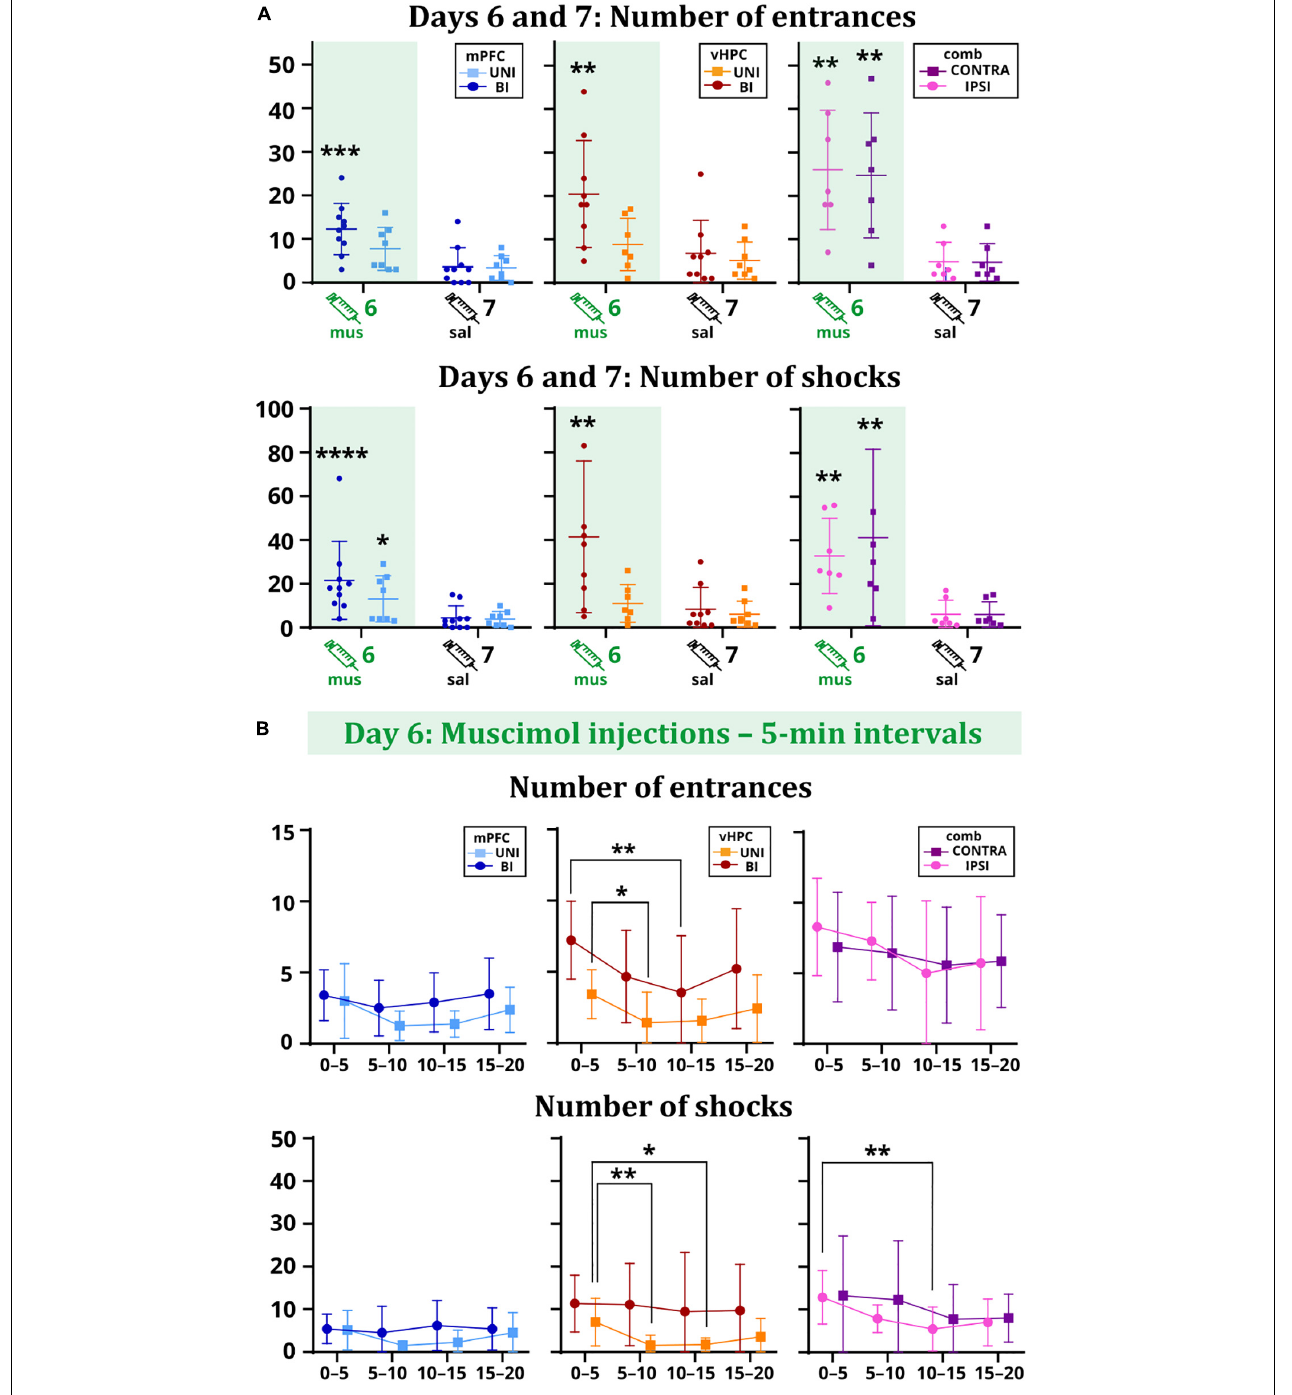
FIGURE 3 | Performance of the rats on days 6 vs. 7 (A) and within the day 6 session (B). (A) The BI/mPFC group increased the number of entrances ( p = 0.0003) and shocks ( p < 0.0001) on the inactivation day. The number of shocks increased in the UNI/mPFC group as well ( p = 0.0147). For the vHPC groups, only the bilaterally inactivated rats showed significant problems with not entering the sector ( p = 0.0012) and received a higher amount of shocks ( p = 0.001). Increased numbers of entrances (IPSI: p = 0.0059, CONTRA: p = 0.0085) and shocks (IPSI: p = 0.0036, CONTRA: p = 0.0045) were observed for both combined groups. (B) The performance of the mPFC groups remained stable over time. Both vHPC groups significantly reduced the number of entrances ( p = 0.0202 for intervals 0–5 vs. 5–10 for the UNI/vHPC group; p = 0.0069 for intervals 0–5 vs. 10–15 for the BI/vHPC group), but only the UNI/vHPC group had a markedly reduced number of shocks ( p = 0.0061 for intervals 0–5 vs. 5–10; p = 0.0326 for intervals 0–5 vs. 10–15). In the combined groups, the number of entrances remained high during the whole session; however, the number of shocks gradually decreased, significantly in the case of the IPSI group between the intervals 0–5 vs. 10–15 ( p = 0.0034). * p < 0.05; ** p < 0.01; *** p < 0.001; **** p ≤